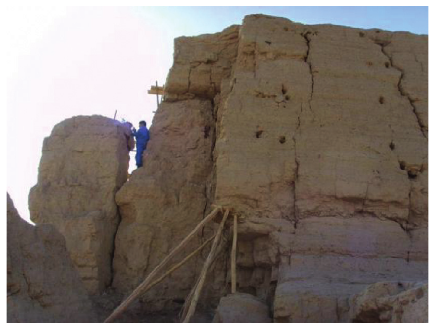
Figure 2: Crack propagation in an earthen